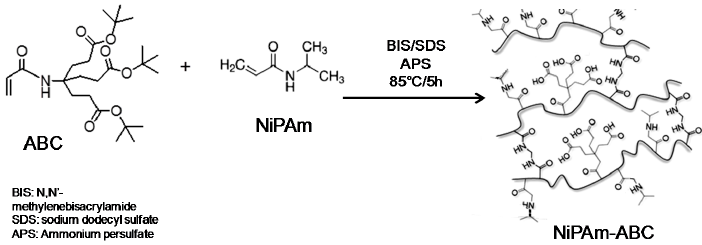
Figure 9. Copolymerization of N -isopropylacrylamide (NiPAm) with 4-acryloylamine-4-(carboxyethyl) heptanodioic acid (ABC). The synthesis of dendronized NGs.